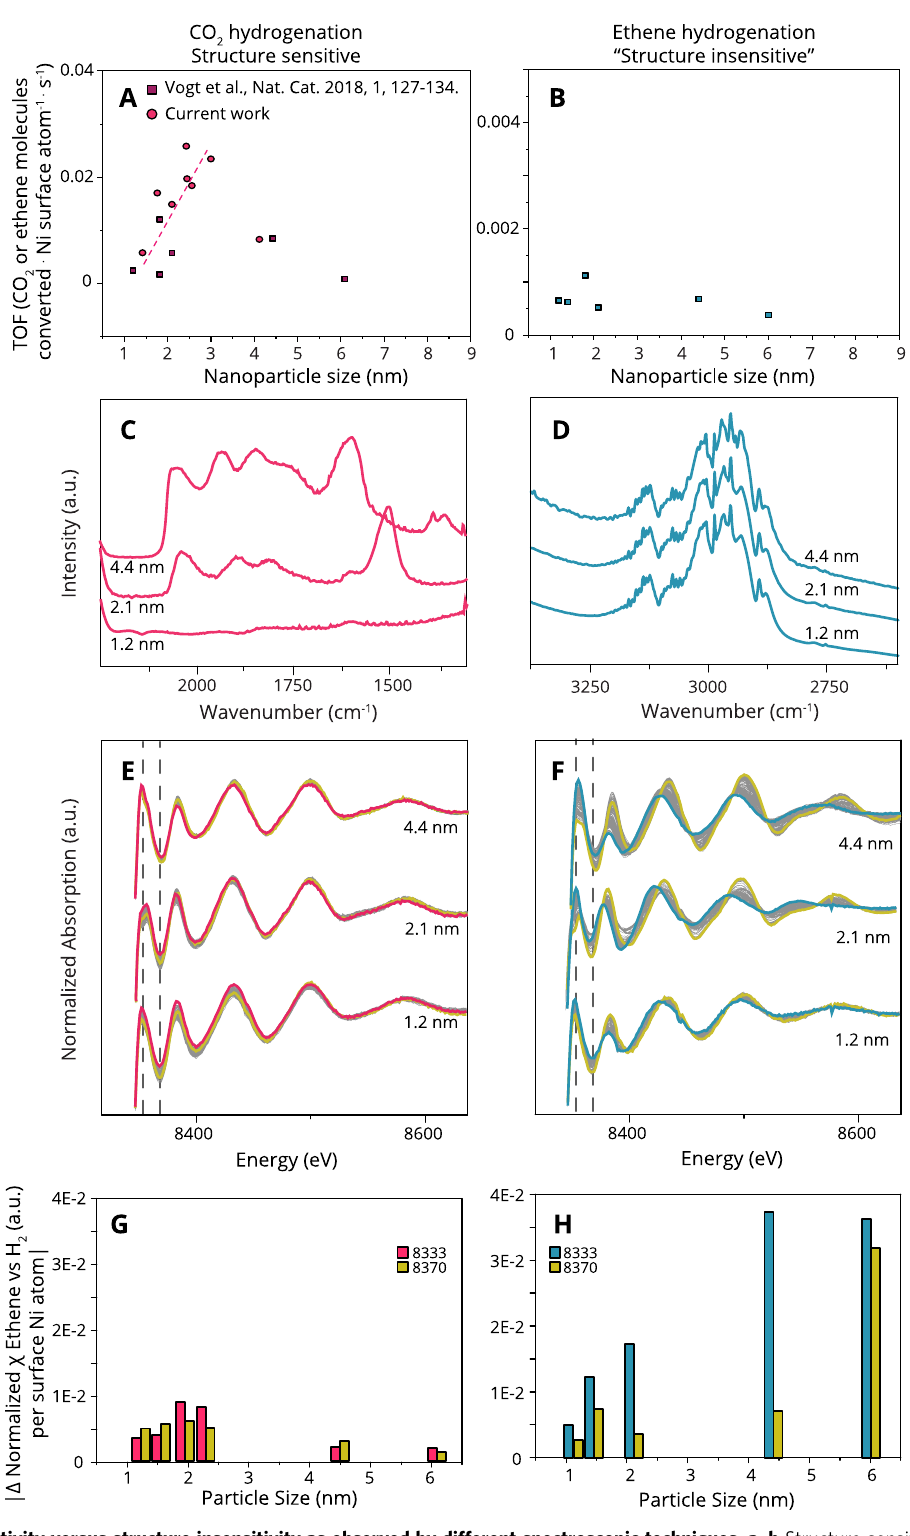
Fig. 1 Structure sensitivity versus structure insensitivity as observed by different spectroscopic techniques. a , b Structure sensitivity versus structure insensitivity plotted on a linear Y-axis. The in fl uence of the Ni mean particle size on TOF for a CO 2 hydrogenation at 300 °C and b ethene hydrogenation at 150 °C. The Supplementary Information S1 shows alternative plots, and an extensive literature search on both structure sensitive, and insensitive reactions. c , d Operando FT-IR spectra during CO 2 hydrogenation at 300 °C and ethene hydrogenation at 150 °C, respectively for three different mean particle sizes of Ni/SiO 2 . X-ray absorption spectra (XAS) with 2 s time resolution obtained upon switching from pure H 2 after reduction, to either CO 2 ( e ) or ethene ( f ) hydrogenation. g , h absolute magnitude of change induced by the onset of catalysis (seen in e , f ) at the Ni K-edge using the largest Δ , at 8333 eV and the second largest Δ at 8370 eV indicated by the dotted lines in ( e , f ) and normalized for available surface area, for CO 2 ( g ) and ethene ( h ) hydrogenation.